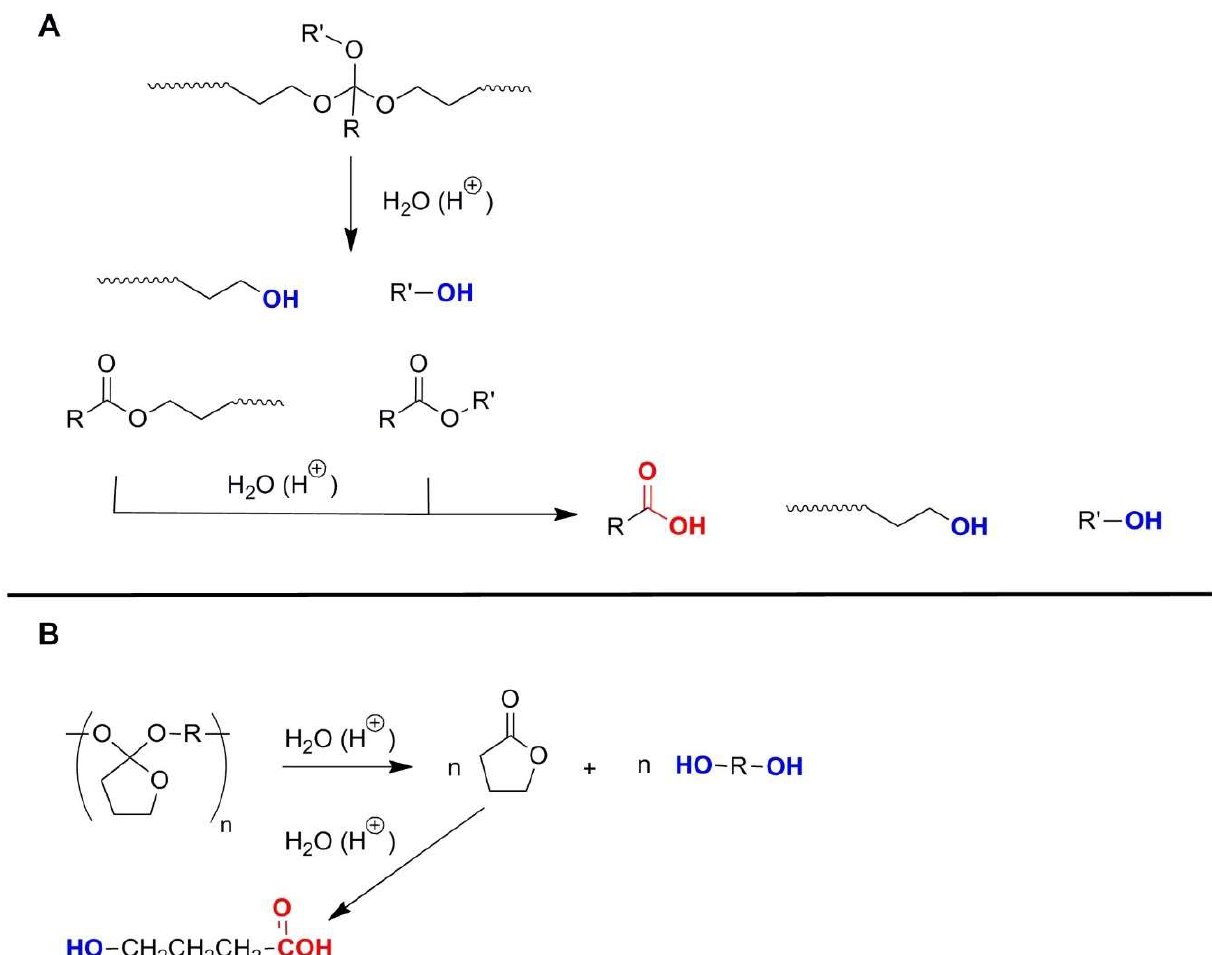
Scheme 9. Schematic illustration of hydrolysis of polyorthoesters ( A )—Class POE V, ( B )—Class POE I.